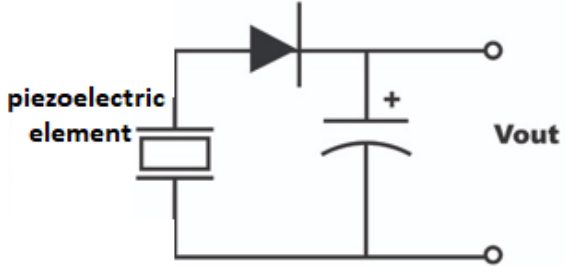
Figure 12. Preliminary circuit to store and deliver harvested energy.